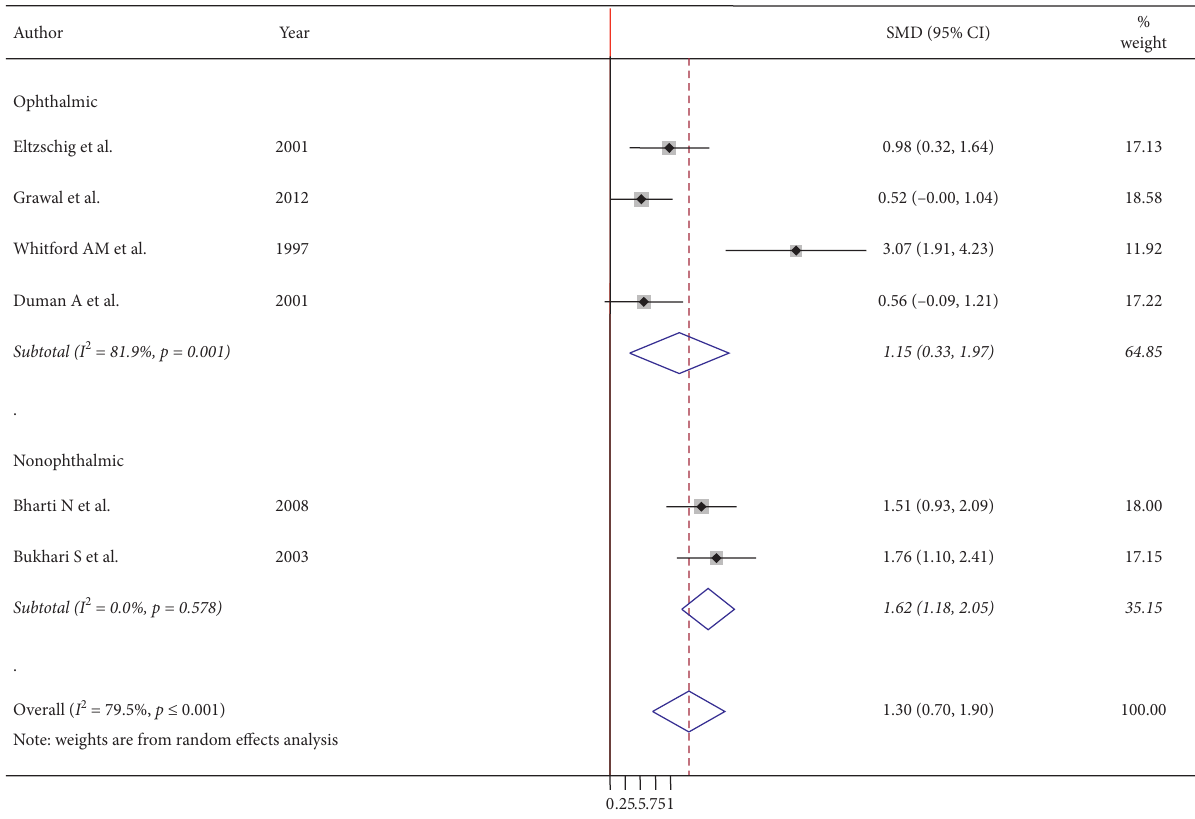
Figure 5: Subgroup analysis of IOP after ETT intubation and LMA insertion by the surgical type. Table 3: Description of studies included in the narrative